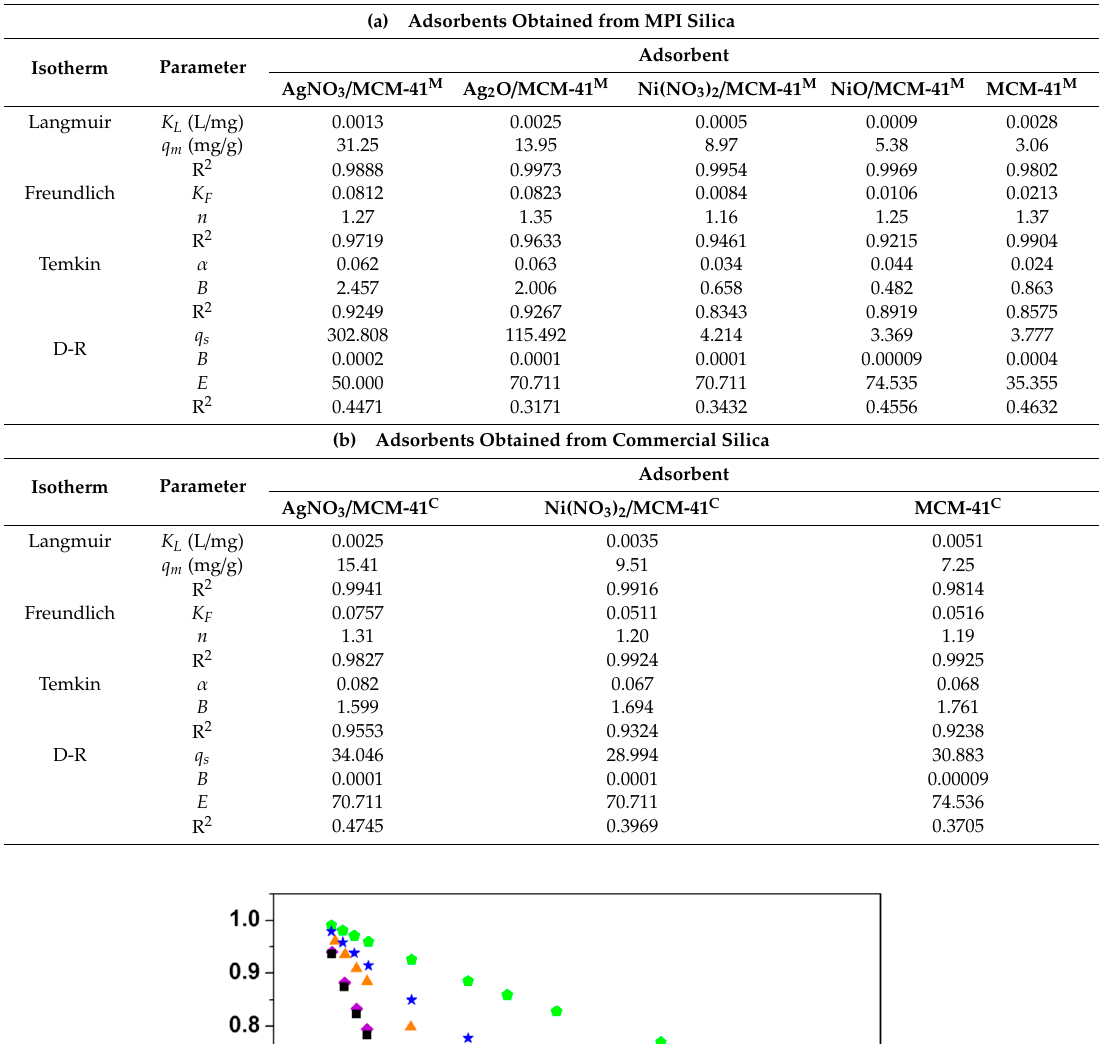
Table 4. Parameters and determination coe ffi cients for Langmuir, Freundlich, Temkin and Dubinin-Radushkevich (D-R) isotherm models.